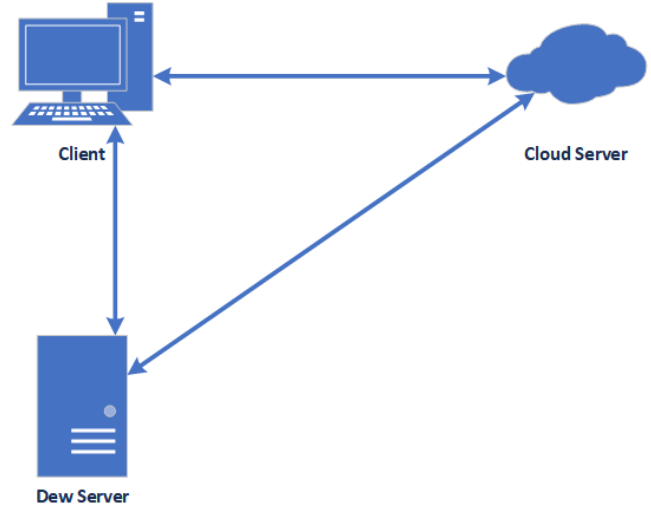
Figure 1. Dew computing